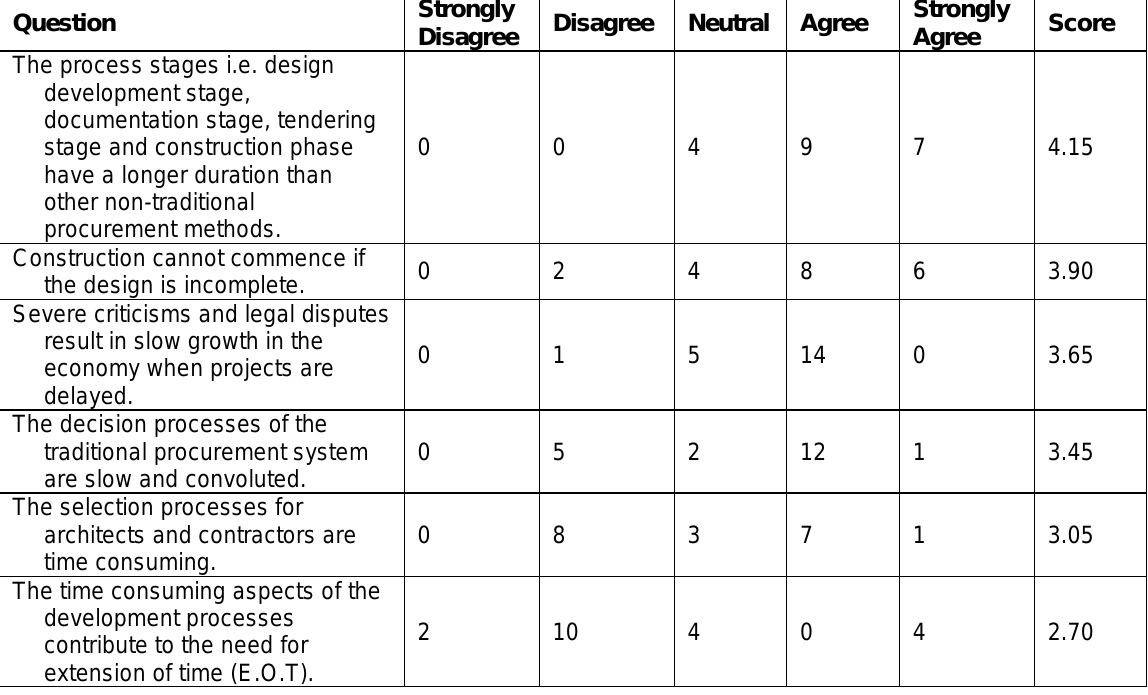
Table 1: Time consuming aspects of the development